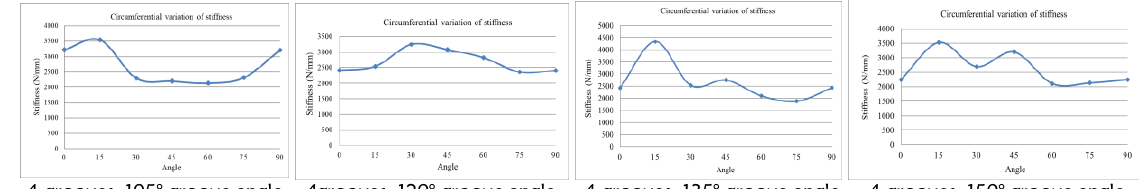
Figure 8b: Circumferential variation of stiffness up to 90° for 4 - grooves ISSFD rings